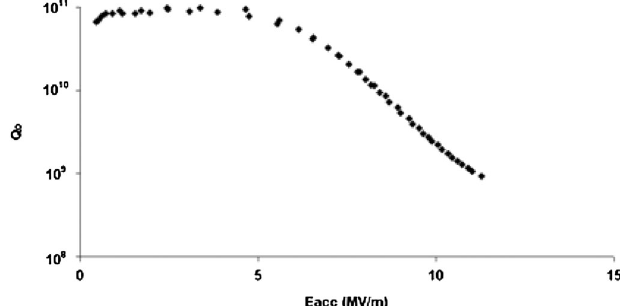
FIG. 8. The rf test of the cavity 1AC03 after 100 (cid:2) m removed with 1–9(40%) and 50 (cid:2) m removed with 3–6.72–0.28 mixture. Q deterioration at low gradient. 0